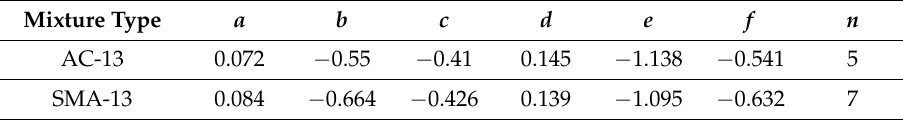
Table 4. Parameters of the nonlinear failure